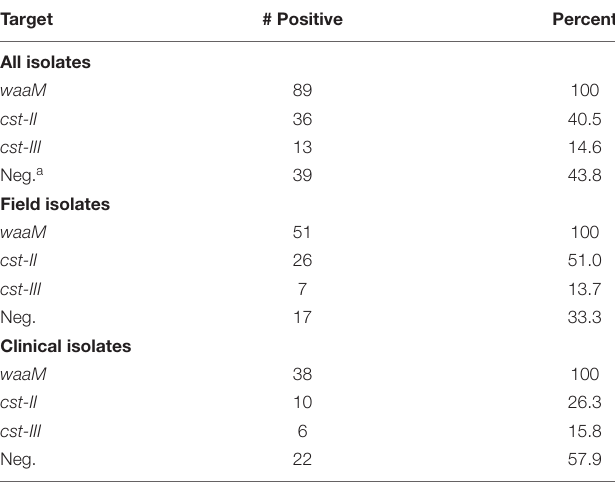
TABLE 2 | Multiplex qPCR screen of 89 C. jejuni isolates.